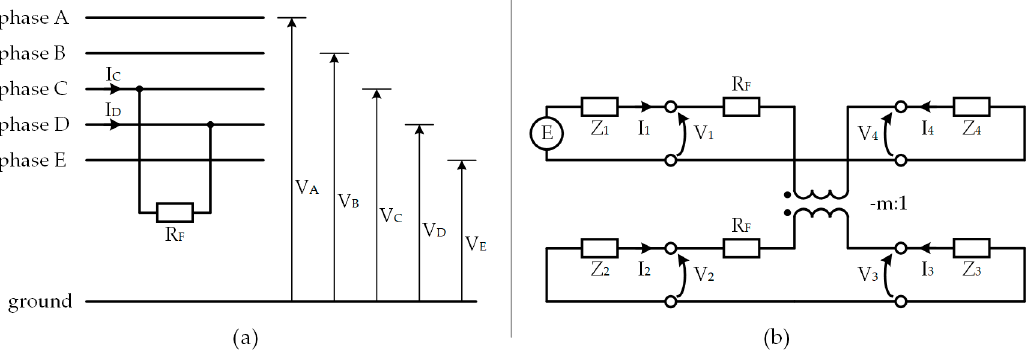
Figure 3. CD fault: ( a ) the five-phase system and ( b ) sequence networks connections.